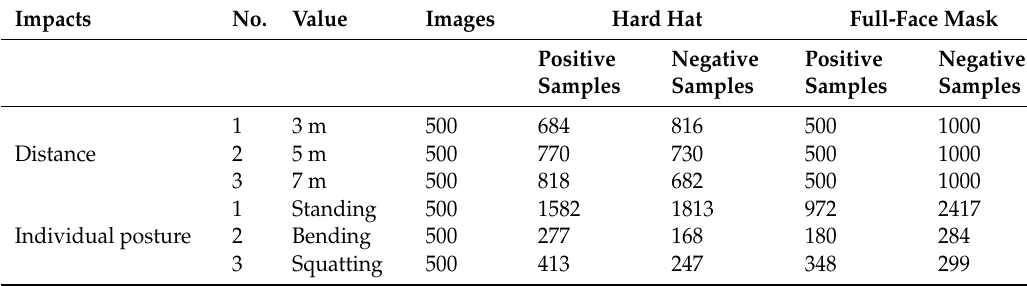
Table 2. Information of collected testing dataset.